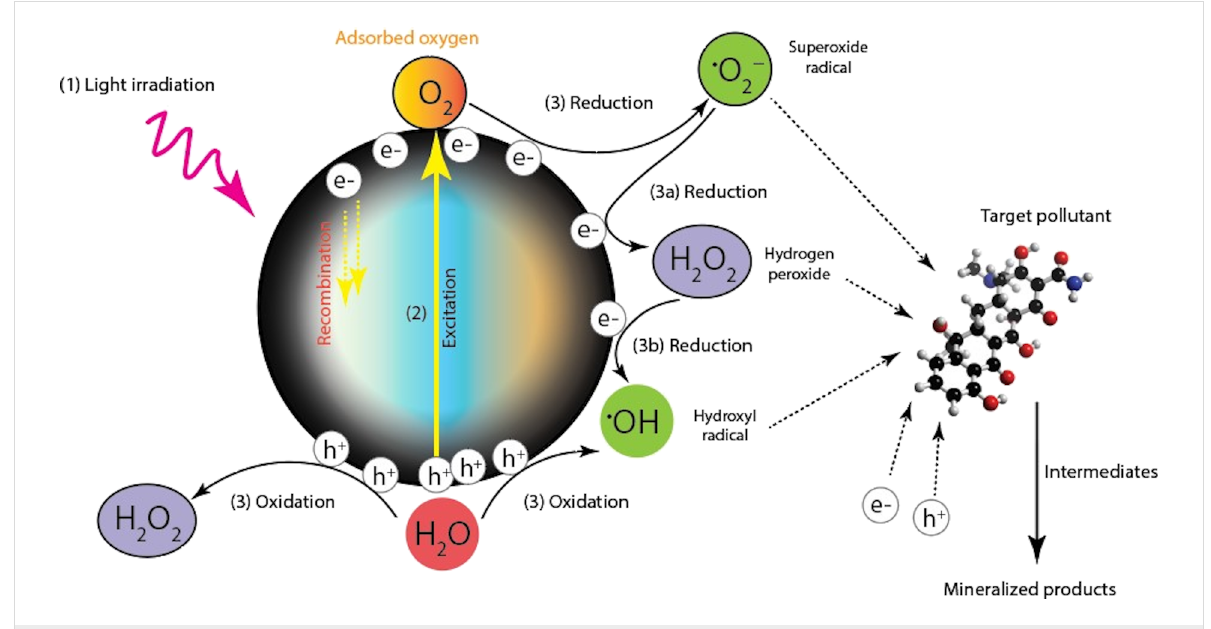
Figure 1: Mechanism of the photocatalytic process used to treat water contaminated with organic pollutants.